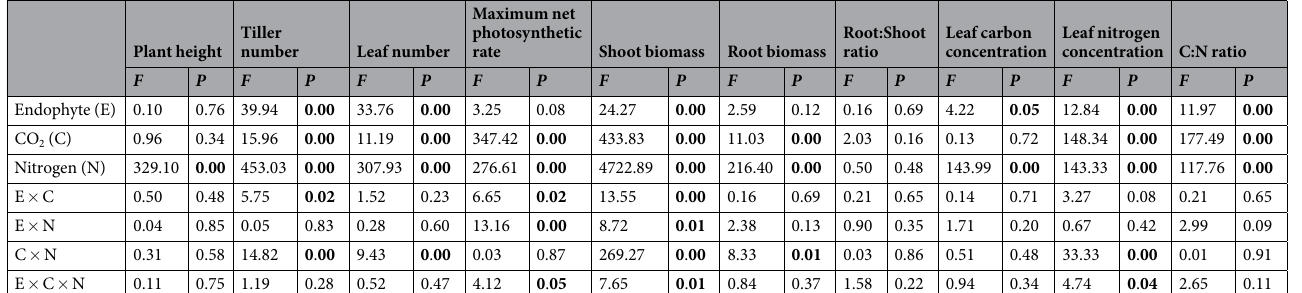
Table 1. Three-way ANOVA for growth characters of endophyte-infected (E + ) or uninfected (E − ) Festuca arundinacea under various CO 2 and nitrogen conditions. Significant P -values are in